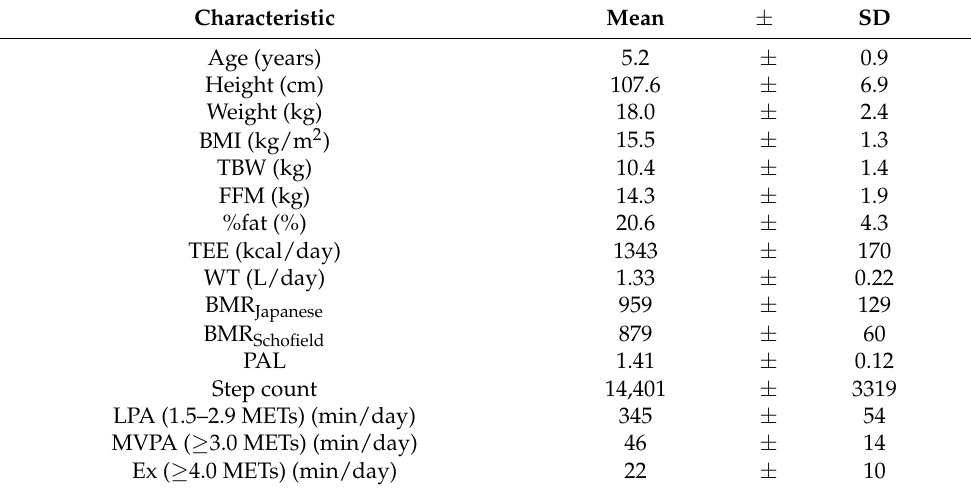
Table 1. Physical characteristics and physical activities of the participants ( n = 41). Characteristic Mean